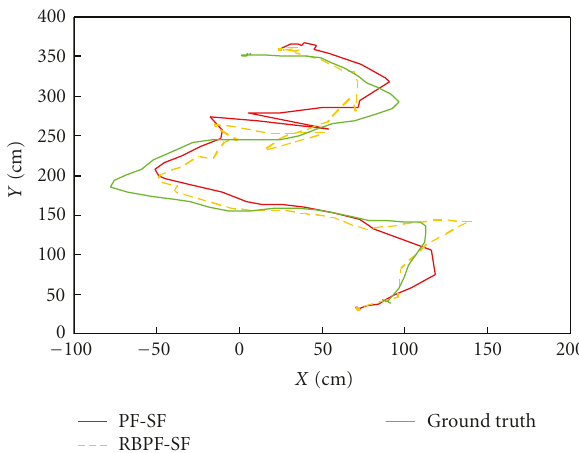
Figure 15: Tracking trajectories of PF-SF, RBPF-SF, and ground truth in the 1st